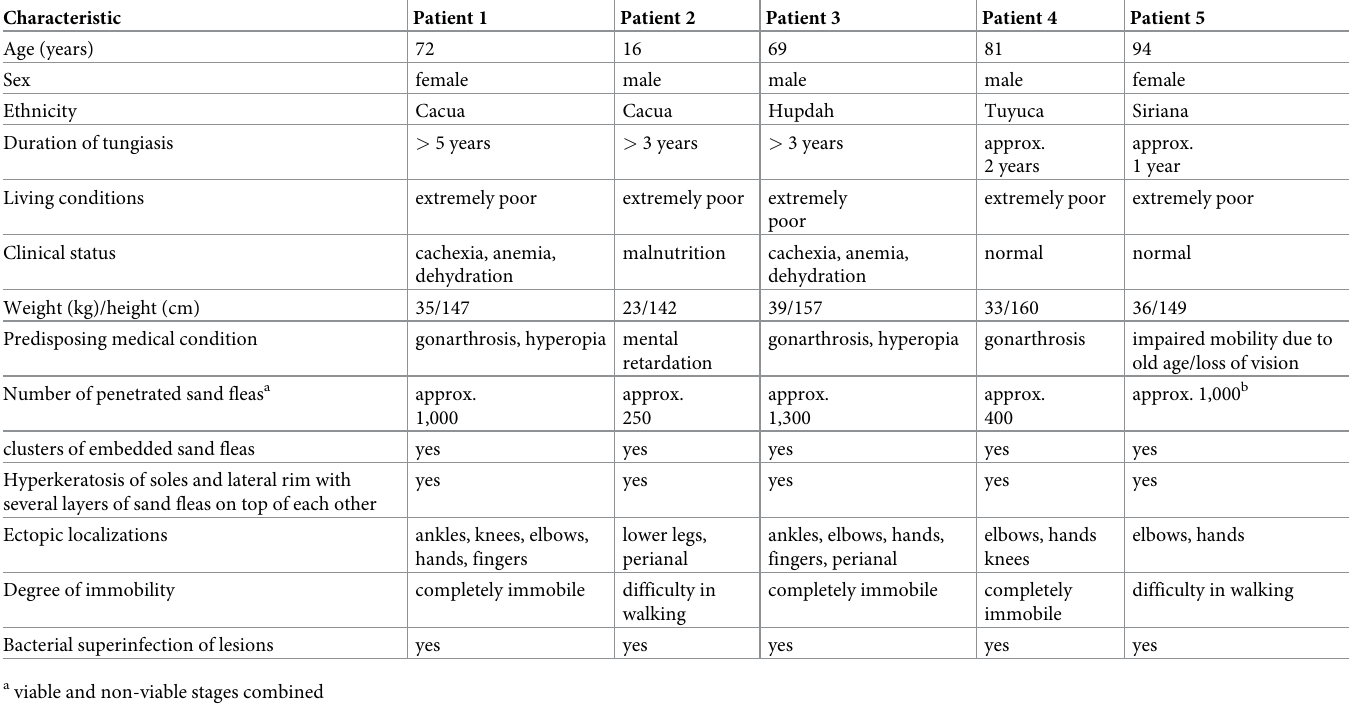
Table 1. Demographic, socio-economic and clinical characteristics of the